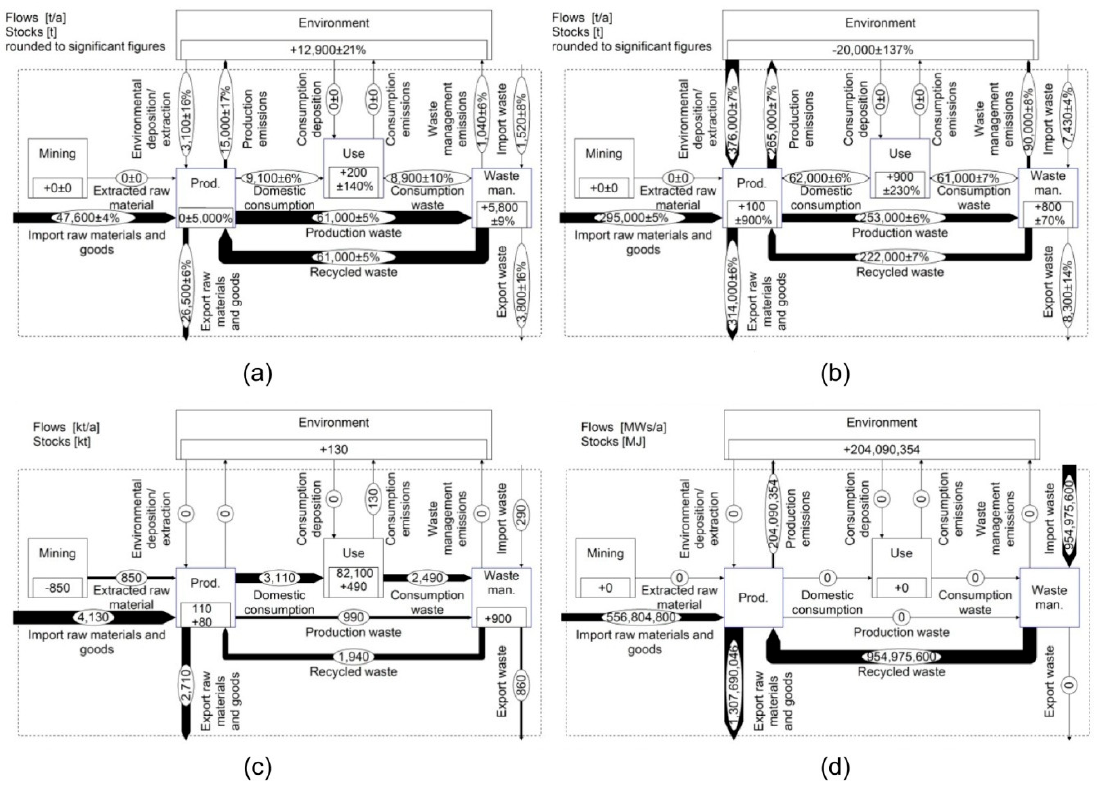
Figure 7. Generic MFA system of the three case studies: ( a ) Austrian P-N system–P; ( b ) Austrian P-N system–N; ( c ) EU28 copper system; ( d ) Energy flows in Karlskoga heat and power plant.